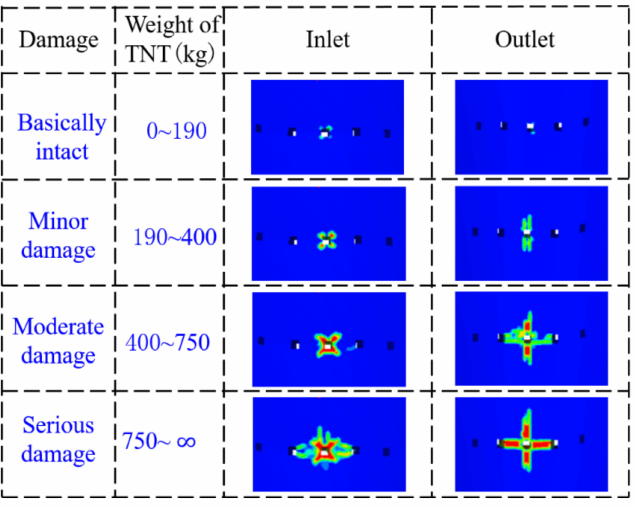
Figure 11. Degree of damage to deep flood discharge holes different masses of